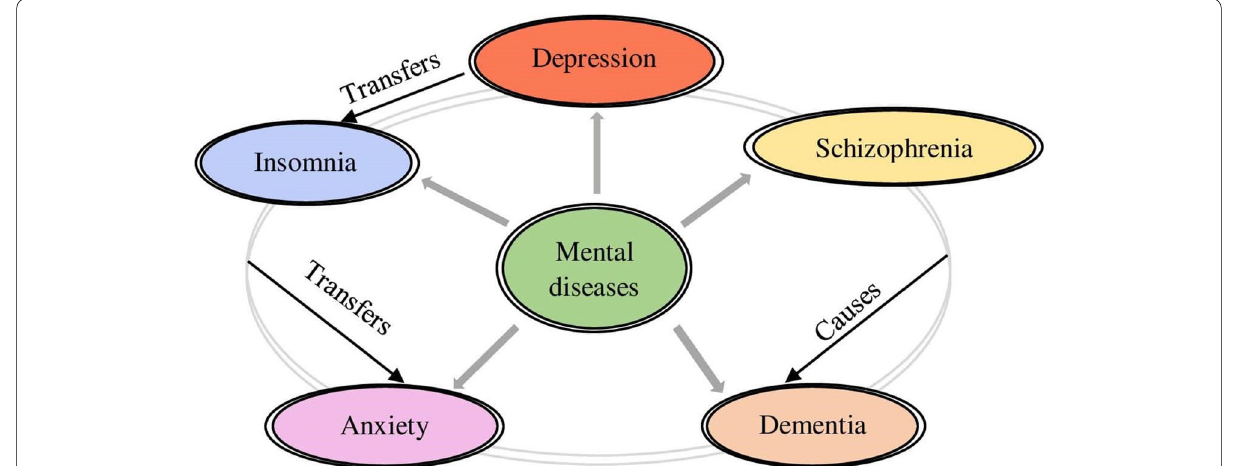
Fig. 5 Mental diseases involved in early